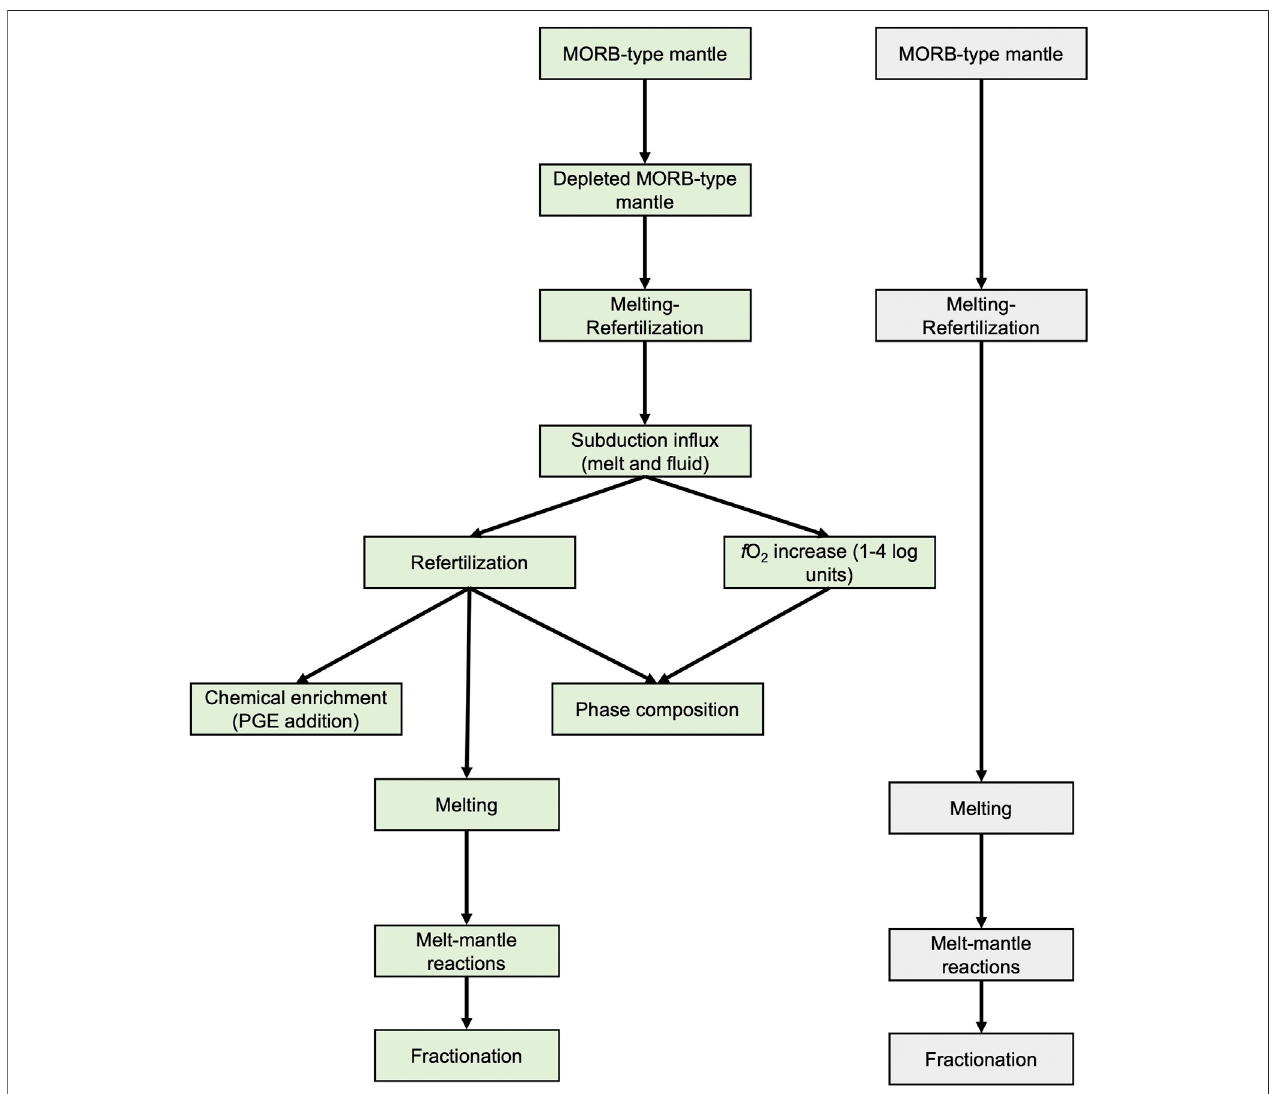
FIGURE 9 | Flow chart outlining key processes controlling the PGE budget in arc and MORB rocks.